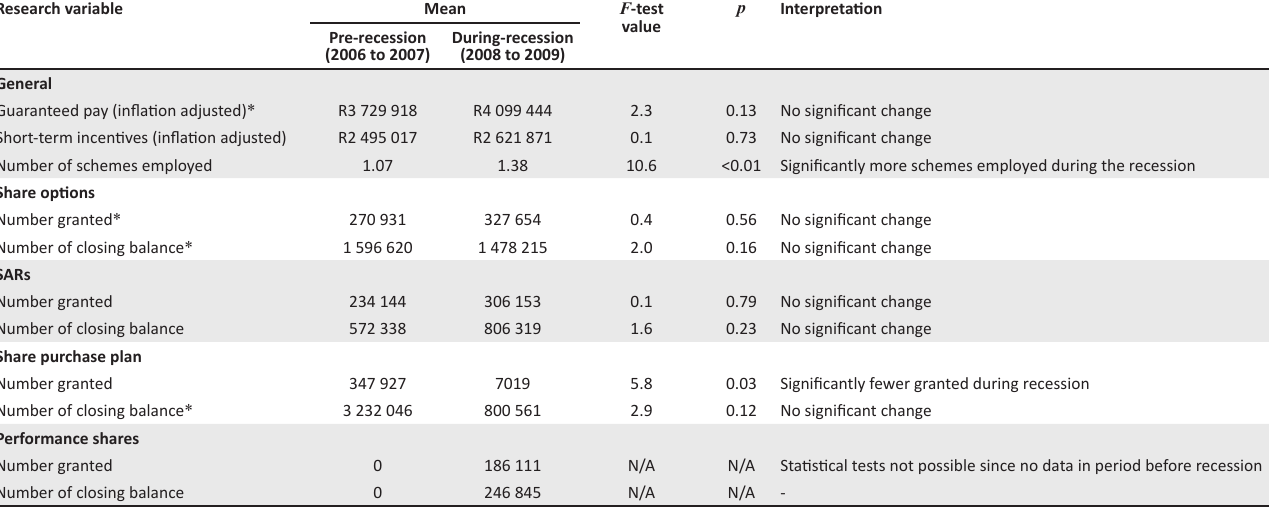
TABLE 4: Descriptive statistics and analysis of variance on pre-recession and during-recession period. Research variable